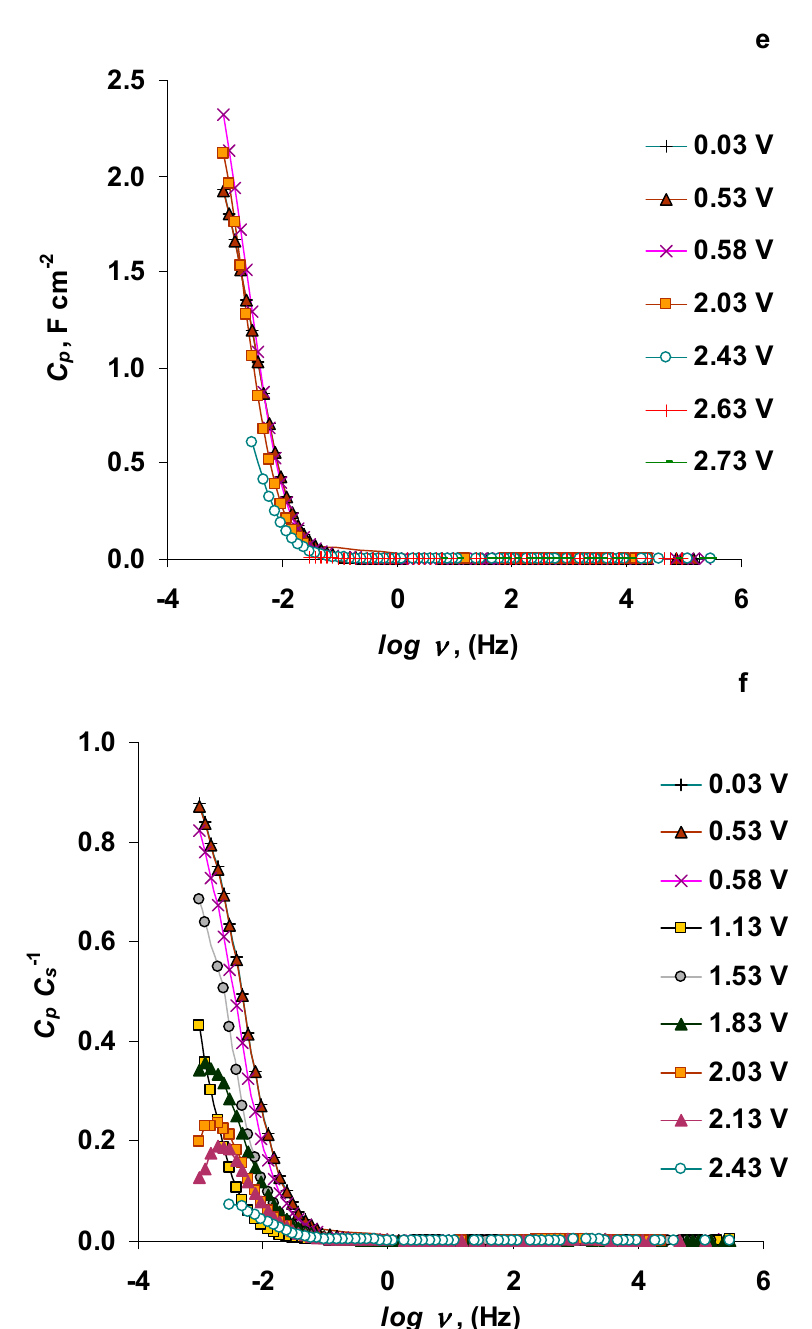
Figure 14. Illustrative data obtained from electrochemical impedance spectroscopy measurements: ( a ) —series resistance ( R s ); ( b ) high frequency semicircle resistance ( R HFS ); ( c ) series capacitance ( C s ) (calculated at EIS modulation frequency ( ν ) ν = 100 mHz); ( d ) parallel capacitance ( C p ) (calculated at ν = 100 mHz) for different consecutively measured electrochemical impedance spectra at various 5 wt % EMImBr solutions in the EMImBF 4 –C(Mo 2 C) system (i.e., C(Mo 2 C) electrode) positive potentials; ( e ) parallel capacitance ( C p ) vs. log ν ( ν marks the modulation frequency in Hz) relationship for various 5 wt % EMImBr solutions in the EMImBF 4 –C(Mo 2 C) system positive potentials; ( f ) C p C s − 1 vs. log ν ( ν marks the modulation frequency in Hz) relationship for various 5 wt % EMImBr solutions in the EMImBF 4 –C(Mo 2 C) system at positive